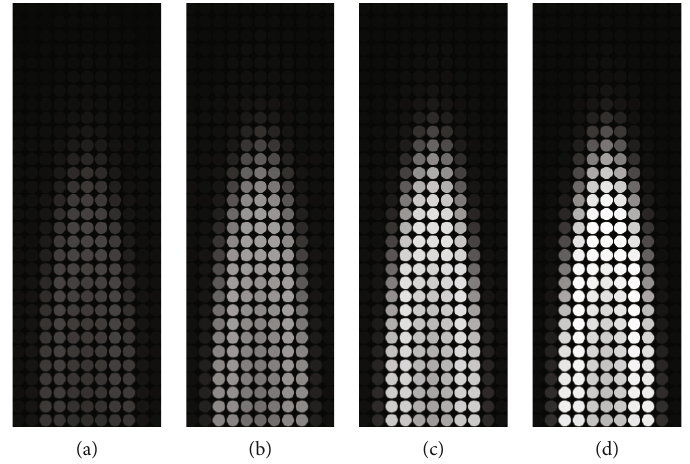
Figure 9: The light fi eld images of the fl ame with scattering albedo (a) ω = 0 : 8 , (b) ω = 0 : 5 , (c) ω = 0 : 2 , and (d) ω = 0